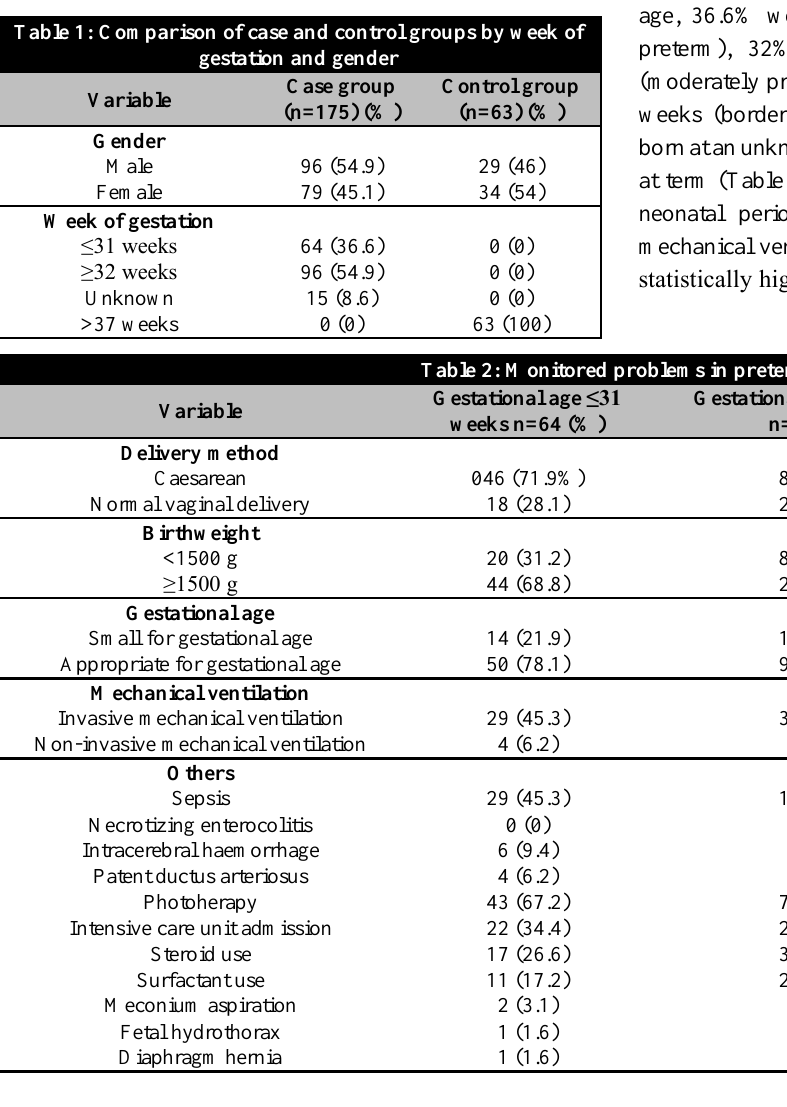
Table 1: Comparison of case and control groups by week of